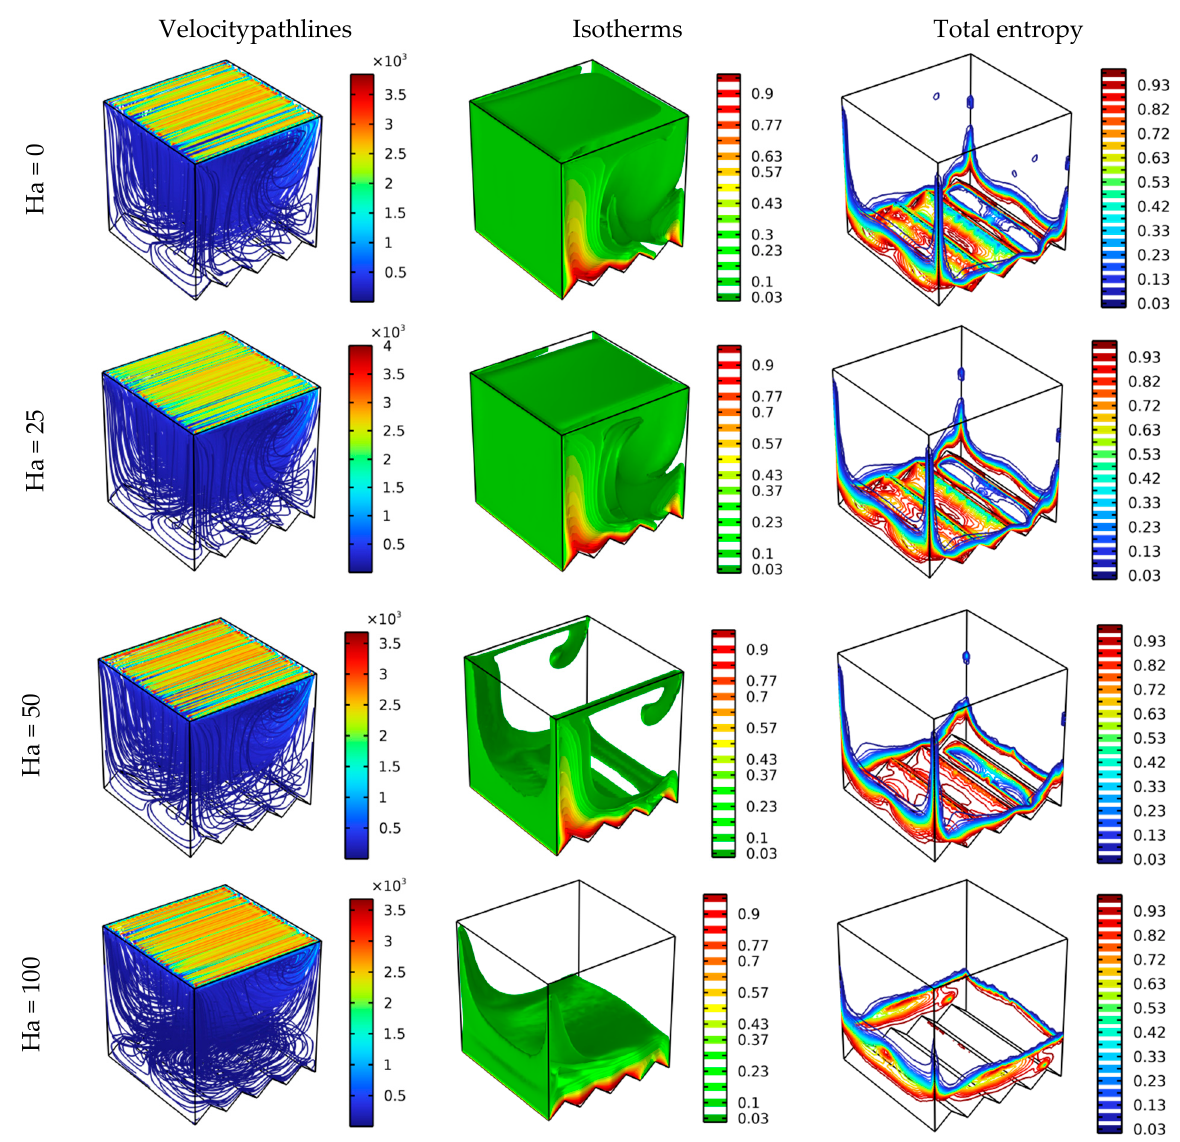
Figure 4. Distribution of the velocity pathlines, isotherm, and total entropy for different Ha values at various scenarios for Da = 10 − 2 , φ = 0.04, and Re = 100.